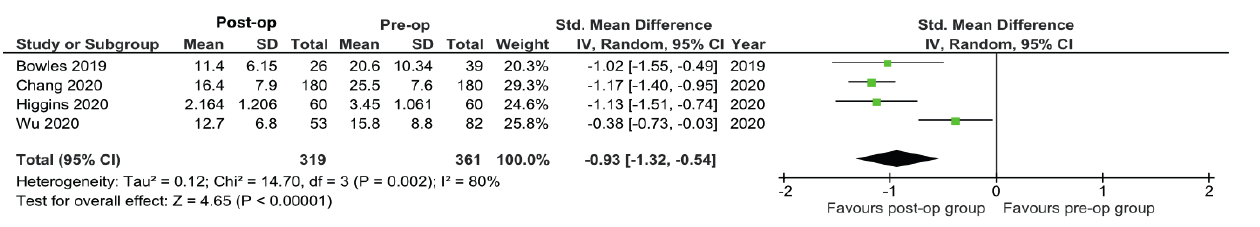
Figure 2. Forest plot of included studies. Forest plot showing significant pooled estimate suggesting a significant difference between the pre-opera- tive and post-operative sino-nasal outcomes which favour the impact of endoscopic sinus